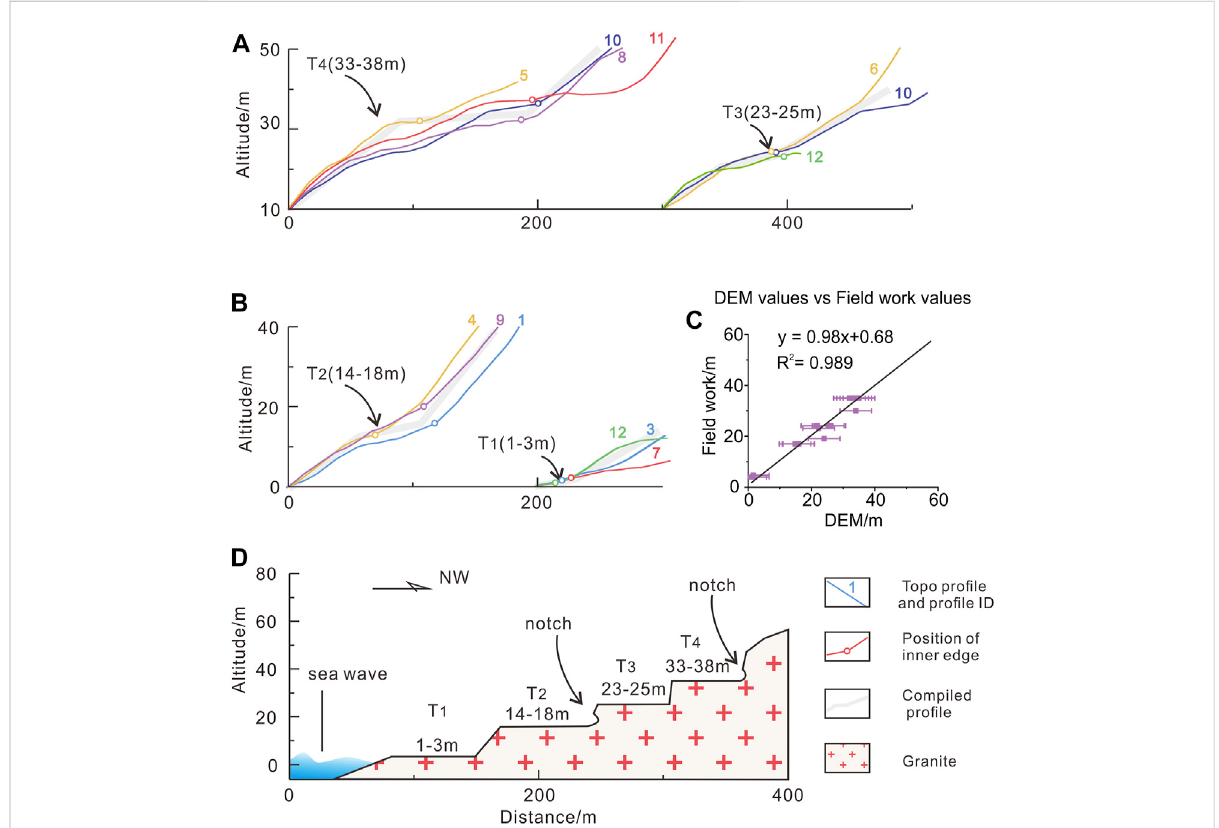
FIGURE 3 Compiled pro fi les of wave-cut platforms reproduced by digital elevation model (DEM)-based topographic pro fi les. The elevations of the slope breaks are at altitudes of 33 – 38 m and 23 – 25 m in (A) , and at 14 – 18 m and 1 – 3 m in (B) . The pro fi le IDs are labeled. (C) Cross-plots of DEM-based inner-edge elevations against the fi eld-based inner-edge elevations. (D) Cross-section of wave-cut platforms in the study